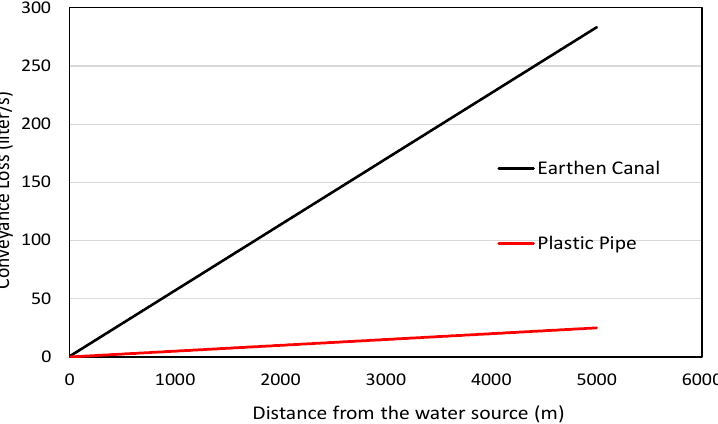
Figure 13. Conveyance loss compensation between earthen canal and plastic pipe.